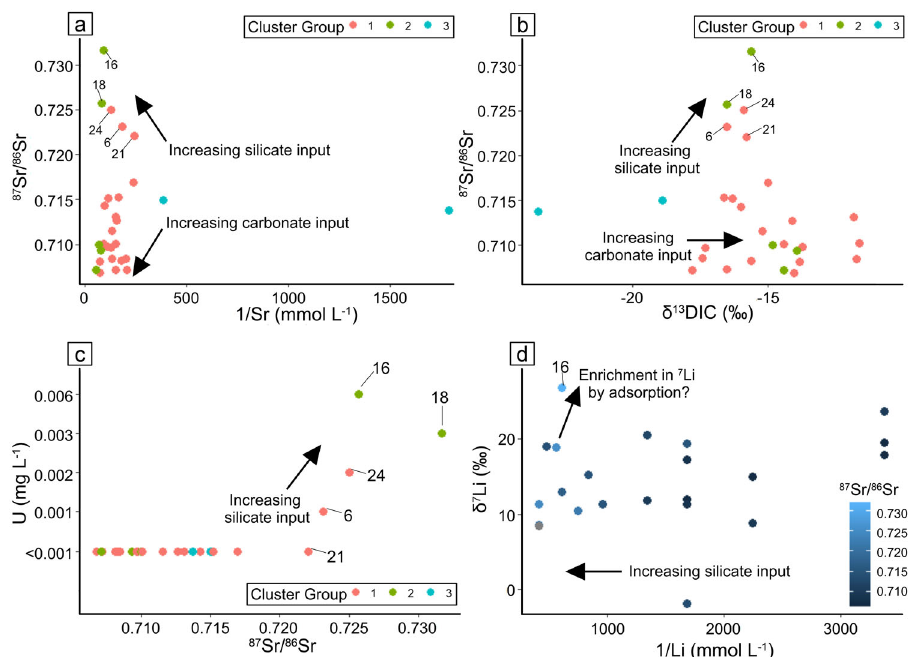
Fig. 4 Biplots. a Biplot of 87 Sr/ 86 Sr ratio ( n = 28) on y -axis with the inverse of Sr concentration (1/Sr (mmol L − 1 ) on the x -axis. Upward and downward trends on the y -axis with increased Sr concentration indicate silicate and carbonate inputs, respectively. b 87 Sr/ 86 Sr ratios vs δ 13 C 87 Sr/ 86 Sr with minimal enrichment in δ 13 C DIC . Plot highlights that samples displaying increased DIC are associated with silicate weathering. Increasing enrichment in δ 13 C DIC with minimal increases in 87 Sr/ 86 Sr are associated with carbonate input. c Biplot with samples trending towards silicate inputs are associated with increased U concentrations. d Biplot of δ 7 Li on y -axis ( n = 21) with the inverse of Li concentration (1/Li (mmol L − 1 )) on x -axis. Scale bar represents 87 Sr/ 86 Sr ratios with dark blue points indicating lower 87 Sr/ 86 Sr (carbonate inputs) and higher Li concentrations and lighter blue points indicating higher 87 Sr/ 86 Sr (silicate inputs) and lower Li concentrations. NB: no 87 Sr/ 86 Sr value available for the grey data point (sample 29) shown to the lower